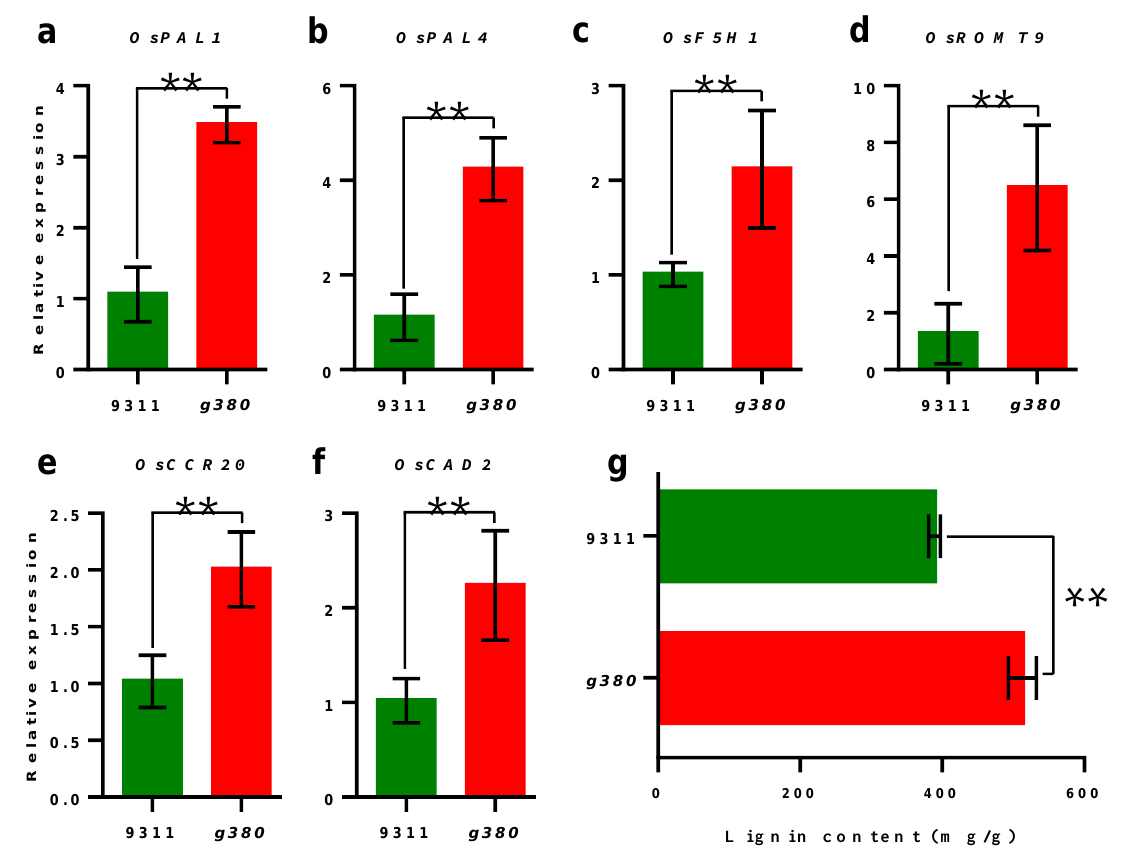
Figure 7. Increased lignin biosynthesis in g380 . ( a – f ) The expression levels of lignin biosynthetic genes in 9311 and g380 leaves. ( g ) Lignin content in 9311 and g380 flag leaves. All data presented as mean value ± SD; hypothesis testing was performed with Welch’s t -test, n = 6, ** means p < 0.01.